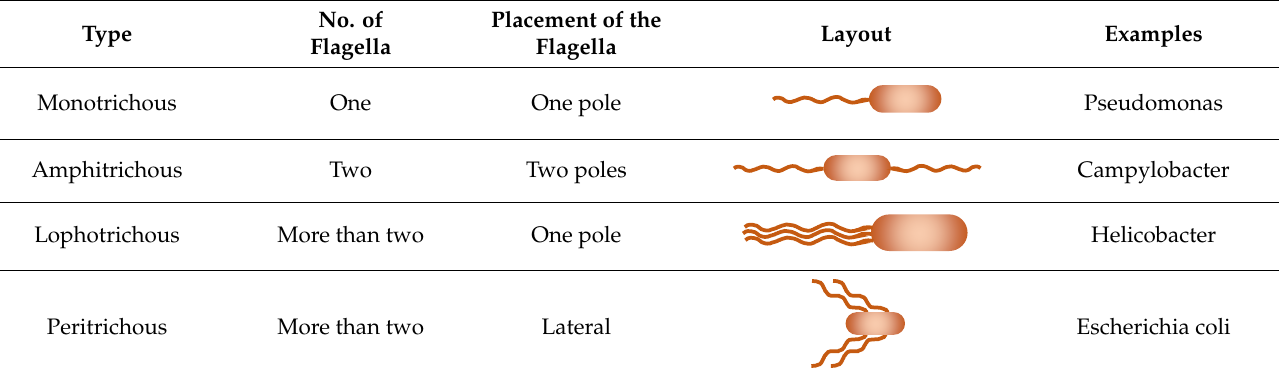
Table 1. Classification of bacteria according to the arrangement of the flagella.